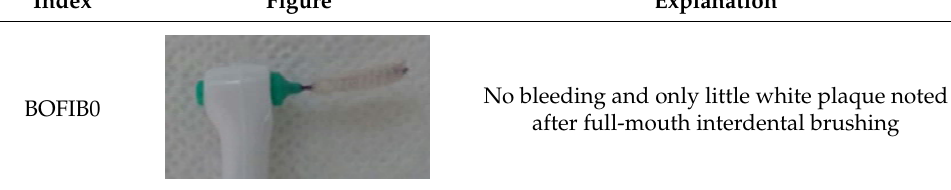
Table 2 . Bleeding on the full-mouth interdental brush (BOFIB) index.